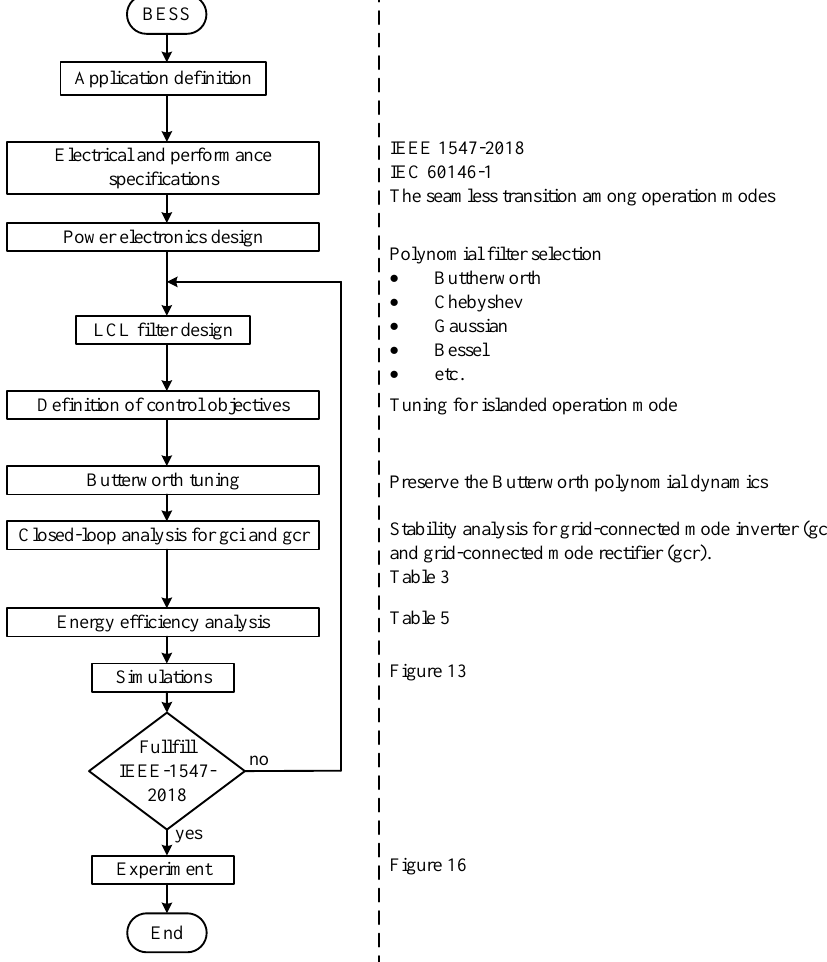
Figure 20. Improved holistic control